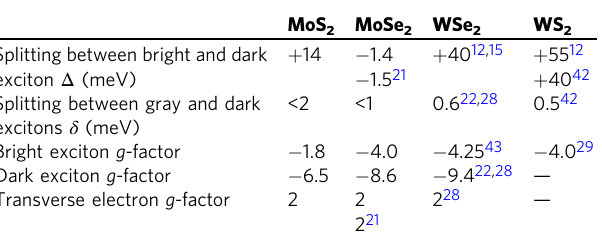
Fig. 1 In-plane magnetic fi eld B // — spin-forbidden dark exciton in MoS 2 monolayer encapsulated in hBN revealed by photoluminescence. a Color map of the variation of the PL intensity as a function of B // (the PL intensity of the bright exciton has been normalized at each fi eld); b PL spectra for magnetic fi elds from 0 to 30 T showing the emergence of the brightened dark exciton at low energy. c Ratio of the PL intensity of dark (X as a function of magnetic fi eld. Inset: sketch of the excitonic fi ne structure. The arrows ↑ and ↓ represent the main spin contribution of conduction and valence electrons involved in the exciton states (see ref. 22 for more details). Table 1 Measured exciton fi ne structure parameters for hBN-encapsulated TMD